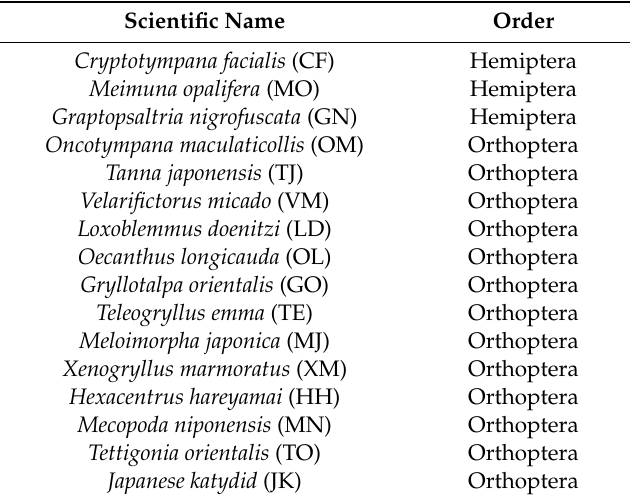
Table 2. Insect song stimuli used in this